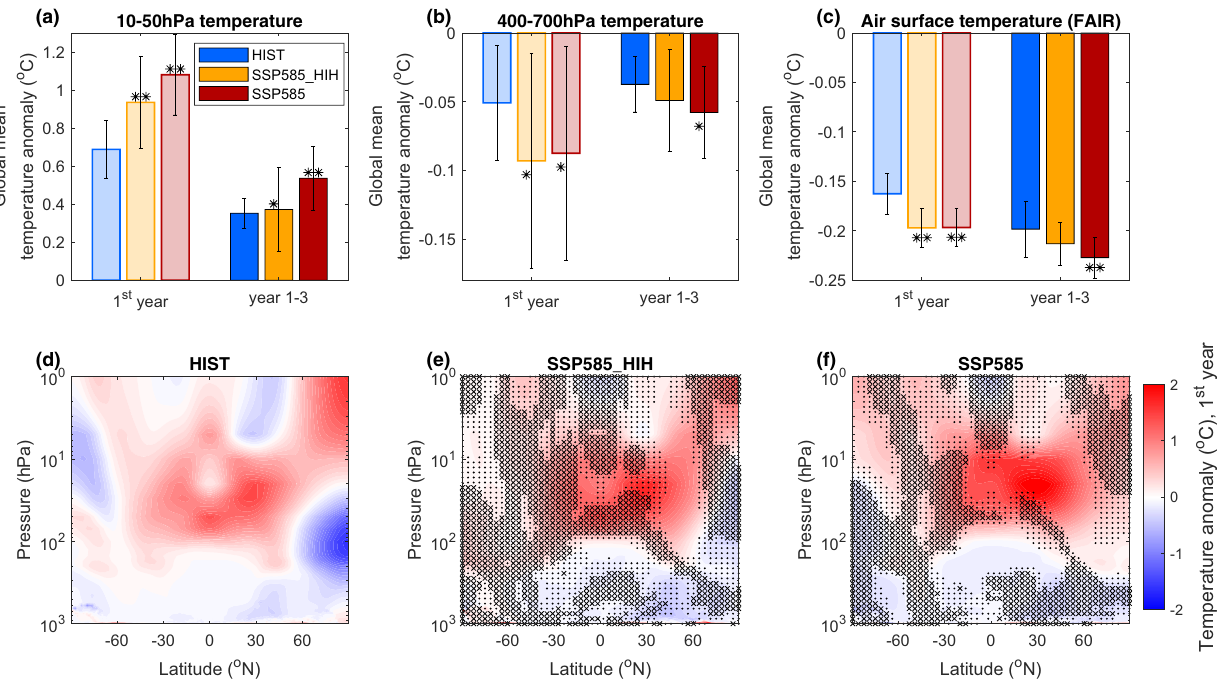
Fig. 8 Temperature response to the large-magnitude tropical eruption. Top row a-c Bar graphs showing the global-mean mid-stratospheric (10 – 50 hPa) temperature anomaly ( a ) the global-mean mid-tropospheric (400 – 700 hPa) temperature anomaly ( b ), and the global mean air surface temperature anomaly as estimated from the net TOA radiative forcing using the simple emission-based climate model FaIR 51, 52 (see Methods) ( c ) for the fi rst post- eruption year and the year 1 – 3 average. Error bars show one standard deviation across the ensemble members; a single (double) star indicates that the change relative to the HIST experiment is signi fi cant at the 80% (95%) level. Bottom row d-f zonal mean temperature anomaly averaged over the fi rst post-eruption year for the HIST ( d ), SSP585_HIH ( e ), and SSP585 ( f ) scenarios. Dots indicate areas, where changes are not signi fi cant at the 95% and crosses, indicate areas where the difference is not signi fi cant at the 80% level. The HIST scenario represents the historical climate and the SSP585 scenario is an upper-end future climate scenario. SSP585_HIH is as SSP585 but uses SO 2 injection heights consistent with the HIST scenario.